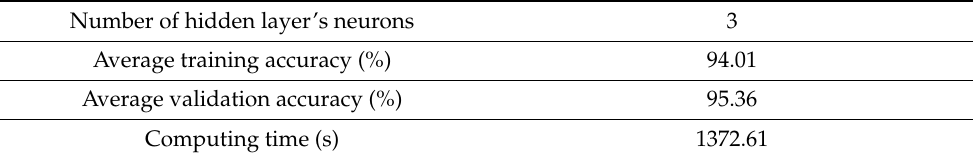
Table 15. Overall statistics of MISO ANN model for depth prediction.